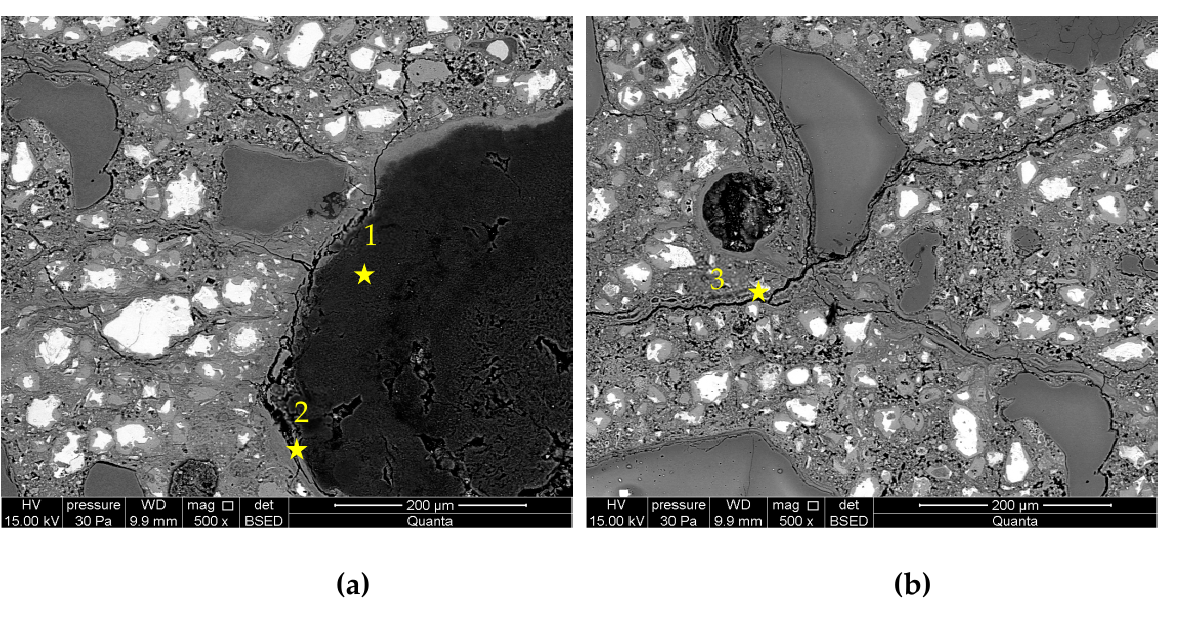
Figure 6. Microstructure images of mortars with lithium nitrate in a ratio of [Li]/[Na + K] = 0.74: ( a ) ASR gel in opal grain, ( b ) ASR gel in cement paste. X-ray microanalysis at location 1–3 (see Table 4).